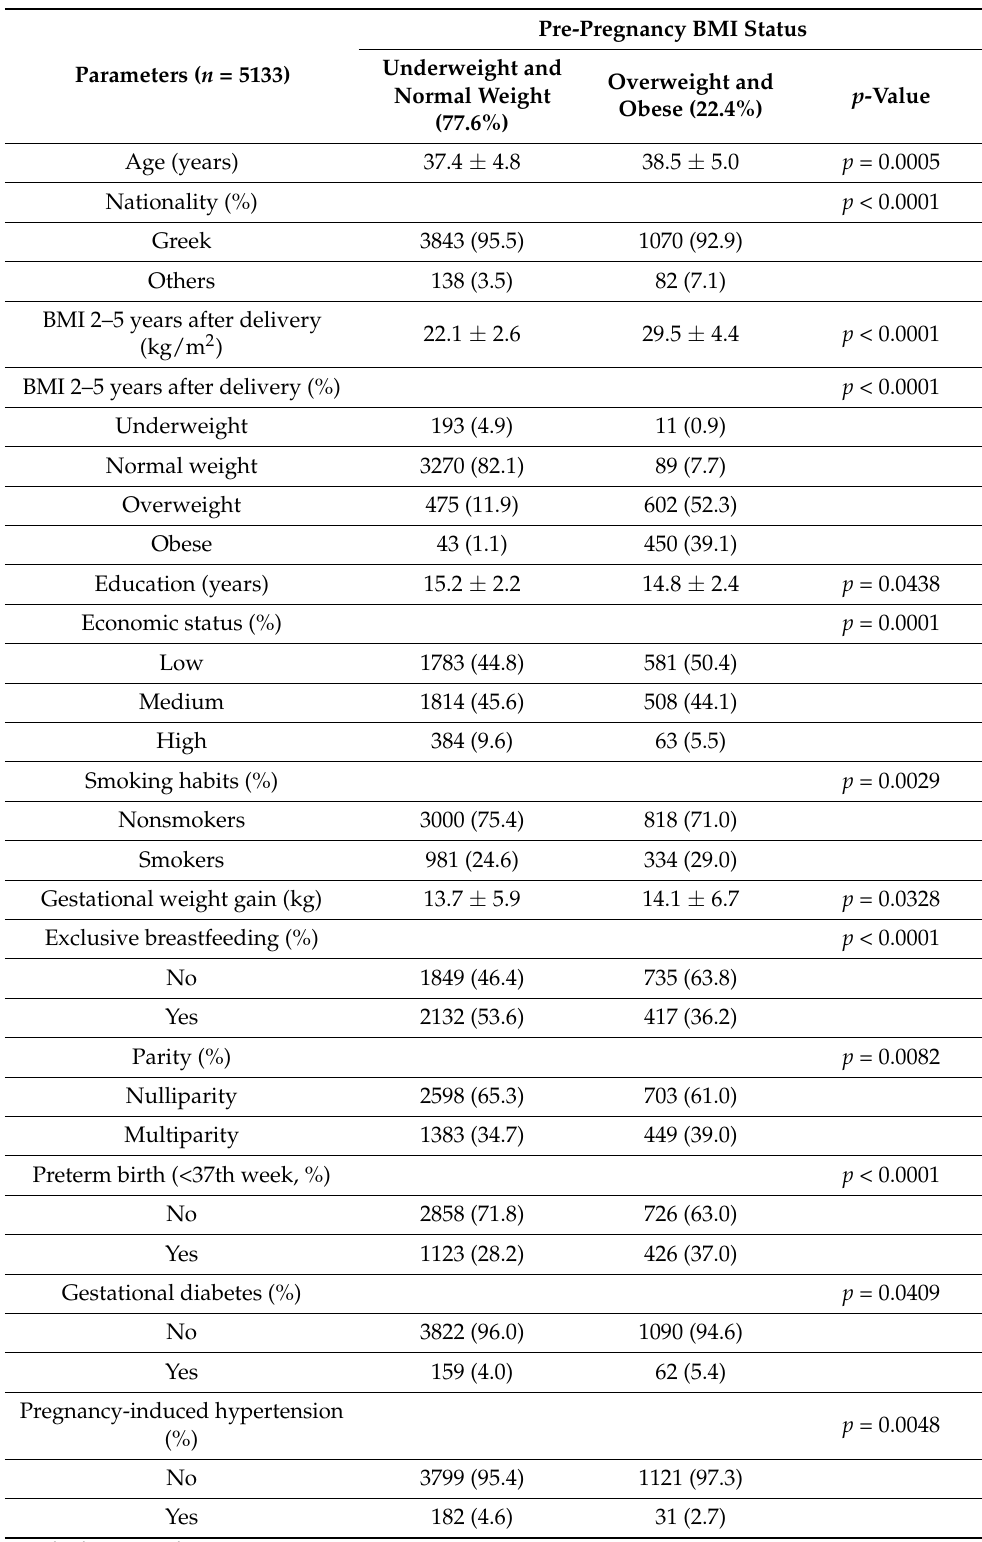
Table 1. Associations of pre-pregnancy BMI status with mothers’ sociodemographic and anthropo- metric characteristics, and maternal